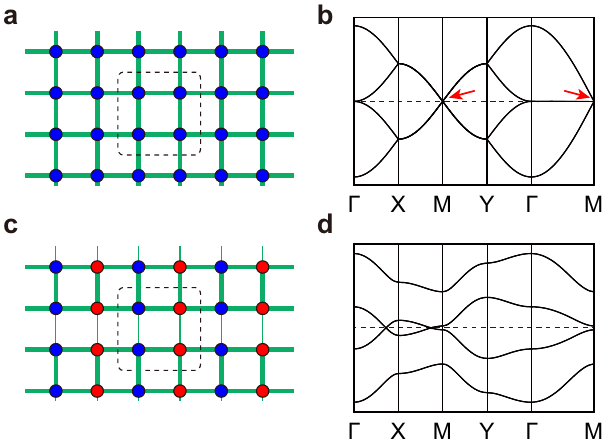
Fig. 1 | Illustration of the 2D SSH model. a , c Schematic drawing of the 2D SSH model. The rectangle lattice has homogeneous hopping ( a ) and alternative hop- ping in y direction and staggered potential energy in x direction ( c ), respectively.